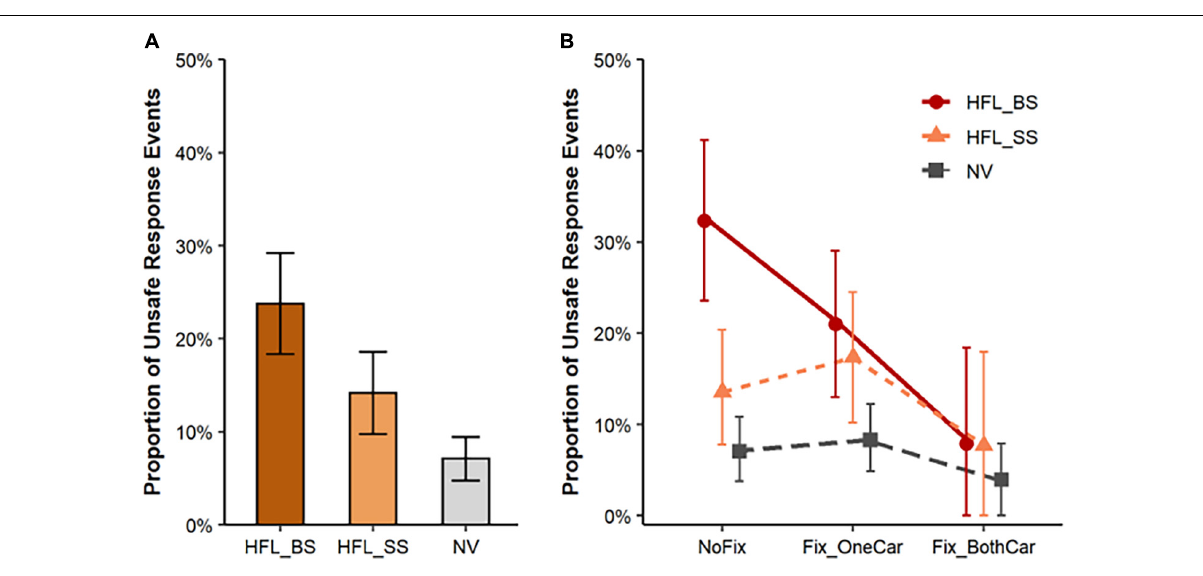
FIGURE 6 | (A) Proportion of unsafe responses to crossing pedestrians when driving through the intersection: comparison between pedestrian approaching side for HFL (blind and seeing side) and NV groups. (B) The proportion of unsafe responses to crossing pedestrians showing a significant two-way interaction between direction of pedestrian approach (blind and seeing side for HFL) and cross-traffic car fixations (no fixation and fixated on one car). Error bars represent